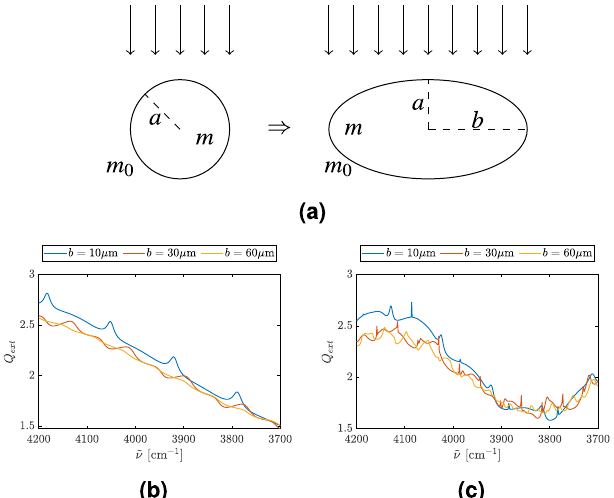
Figure 5. We are evaluating a system that transforms from a disk with radius a into an ellipse. The parameter that describes the height of the ellipse is its semi-major axis, a , which is kept constant and equal to the radius of the disk. We deform the scatterer by increasing the semi-major axis, b , of the ellipse. The refractive index of the scatterer is m and the refractive index of the surroundings is m 0 = 1 . The light is entering the system from above. Frame ( b ) and ( c ) show how Q ext changes as the deformation of the ellipse increases. The semi-major axis, a , of the ellipse [see frame ( a )] is kept constant at a = 10 µ m, and b is selected to be 10 µm (blue line, i.e., a disk-shaped scatterer), 30 µm (red line) and 60 µm (yellow line). The refractive index is ( b ) 1.3 and ( c )